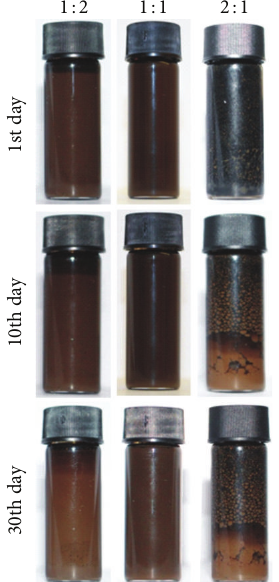
Figure 7: Photographs of fresh emulsions (1 day) and after 10 and 30